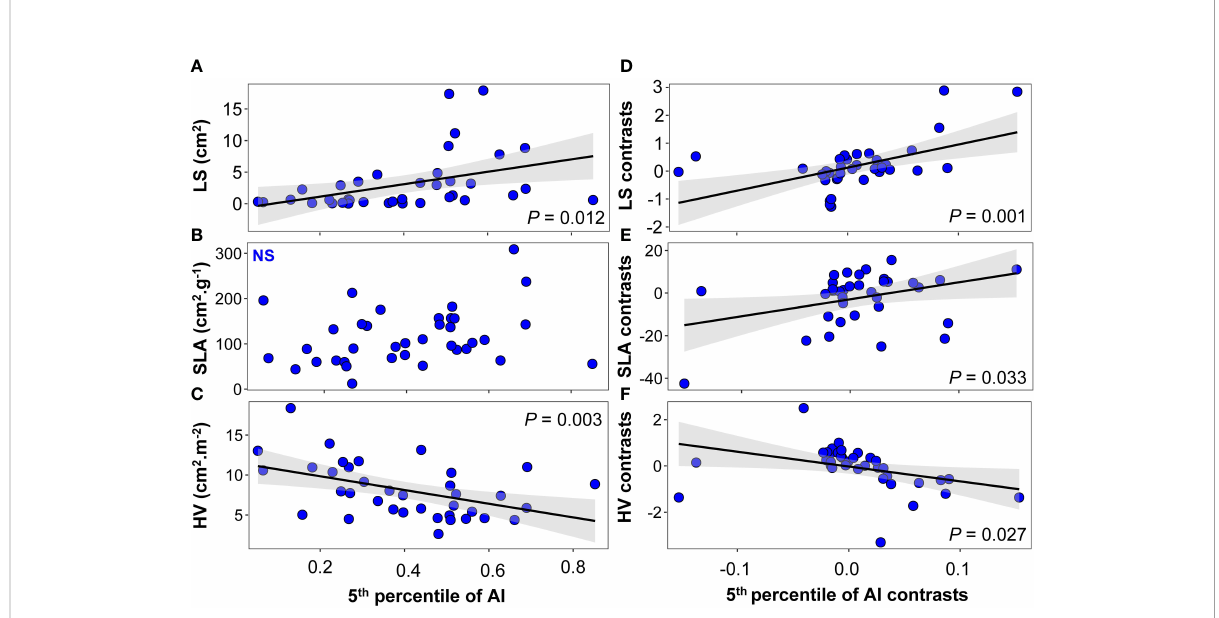
FIGURE 6 Relationships between morphological traits and the 5th percentile of the aridity index (AI) at the species level: (A – C) linear regression between morphological traits and the 5th percentile of AI; (D – F) phylogenetically independent contrast (PIC) linear regression between morphological traits and the 5th percentile of AI. Solid black lines indicate the linear trends of the 5th percentile of the AI changes of morphological traits, and shallow gray bands represent 95% con fi dence intervals. N.S., non-signi fi cant